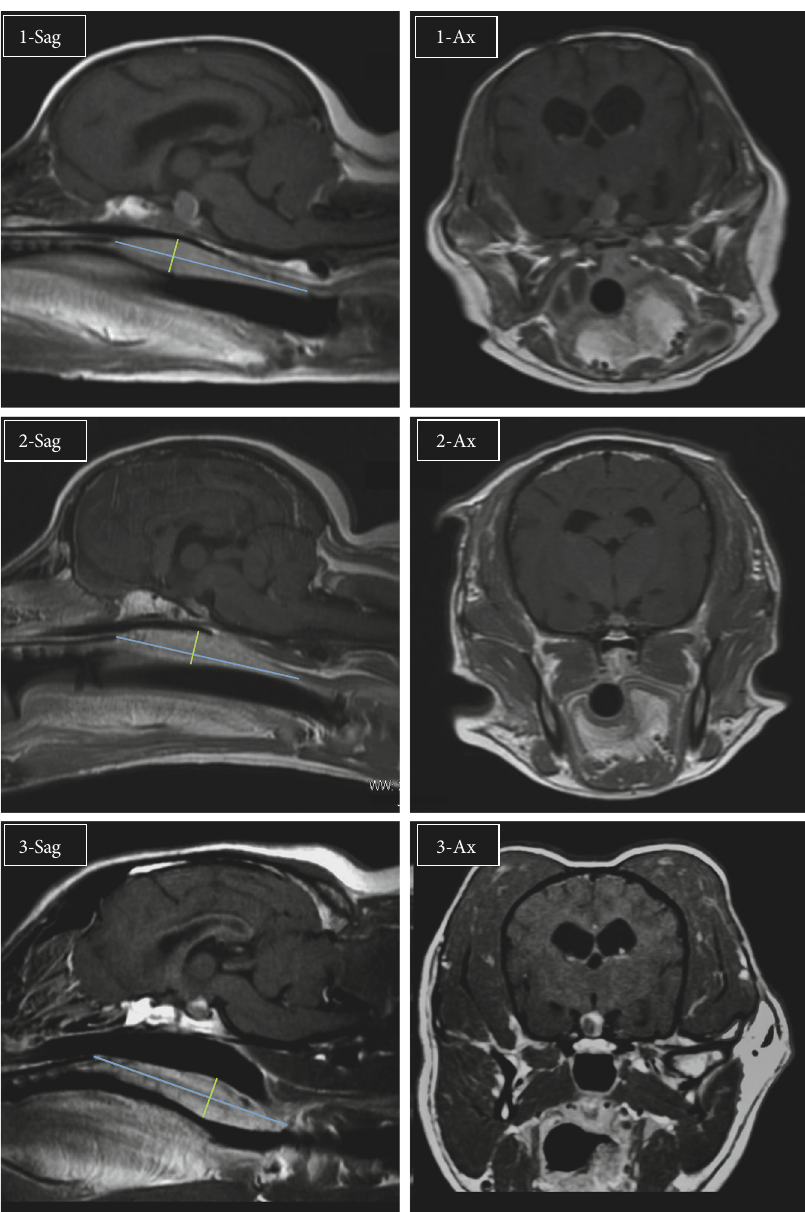
Figure 1: MRI images of the pituitary gland and soft palate of the three dogs in this study. 1-Sag, 2-Sag, and 3-Sag: gadolinium-enhanced T1-weighted images of middle-sagittal section in cases 1, 2, and 3, respectively. 1-Ax, 2-Ax, and 3-Ax: gadolinium-enhanced T1-weighted image of the middle-axial section in cases 1, 2, and 3, respectively. The cranial MRI scans were performed using a 1.5T superconducting MR imaging system (Visart; Toshiba, Tokyo, Japan) or a 3.0T superconducting MR imaging system (Signa HDxt; GE Healthcare, Tokyo, Japan) under the following conditions: slice thickness of 2 mm with no slice gap, matrix of 160 × 256 , and fi eld of view of 12cm (1.5 T MRI) or slice thickness of 2 mm with no slice gap, matrix of 320 × 256 , and fi eld of view of 15cm (3.0 T MRI). T1- and T2- weighted images were taken with a repetition time/echo time of 410/15ms and 4,000/100 ms, respectively. The length of the soft palate was measured as a straight line from the end of the hard palate to the caudal end of the soft palate in the middle-sagittal section (blue lines). The thickness of the soft palate was measured perpendicular to this line, and the maximum value was recorded (green lines). MRI: magnetic resonance